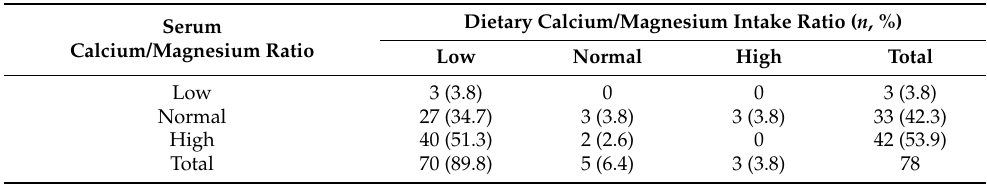
Table 3. Number and percentage of cases with deficient/adequate calcium/magnesium intake ratio versus normal/abnormal serum calcium/magnesium ratio ( n =